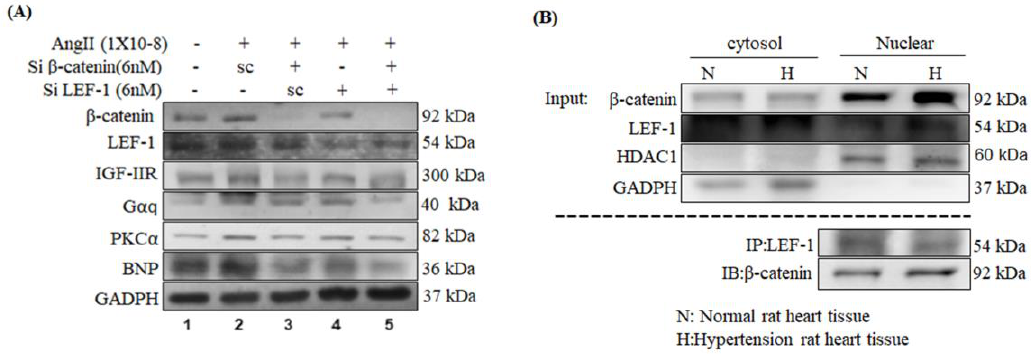
Figure 4. E ff ect of knockdown of β -catenin and / or LEF-1 on IGF-IIR pathway in H9c2 cells. ( A ) H9c2 cells were treated with Ang-II (100 nM) and incubated for 24 h. Next, they were transfected with si-RNAs (6 nM) against β -catenin, or LEF1, or both, and incubated for another 24 h. At the end of 48